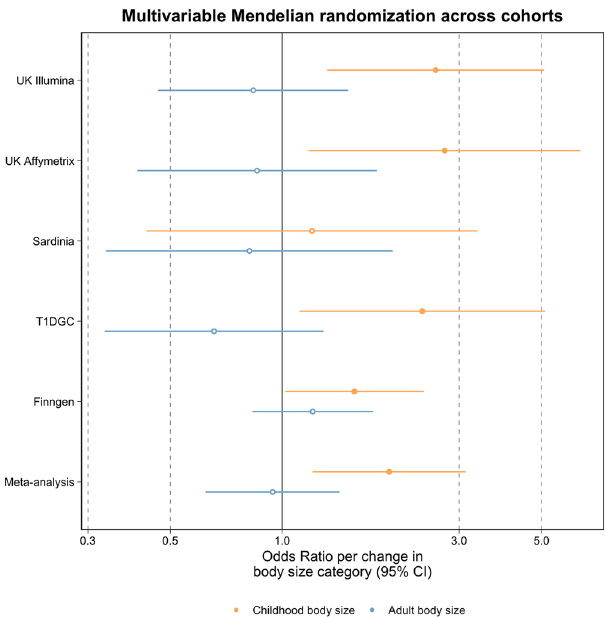
Fig. 3 A forest plot depicting multivariable Mendelian randomisation estimates of childhood body size on type 1 diabetes risk for each study contributing to the meta-analysis. Multivariable Mendelian randomisation analyses of childhood (yellow) and adult (blue) body size ( n = 453,169) on type 1 diabetes risk were undertaken in each contributing study to the large- scale meta-analysis used in this work ( n = 173,981). Odds ratios are per change in body size category. 95% CI 95% con fi dence interval. Central estimates are illustrated as circles which were fi lled when con fi dence intervals did not overlap with the null. T1DGC Type 1 Diabetes Genetics Consortium. The data underlying this fi gure can be found in Supplementary Data